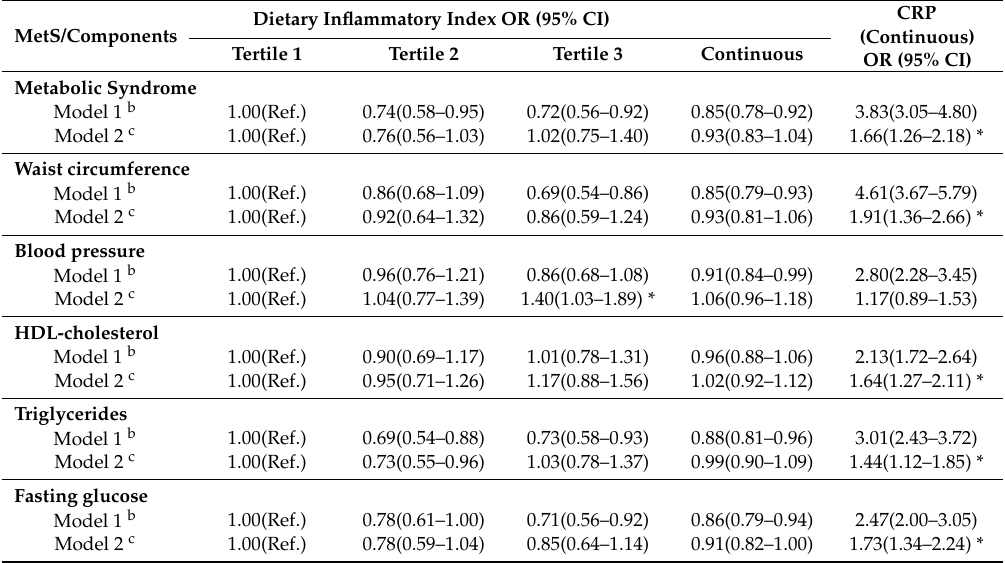
Table 3. Association between the incidence of MetS (components) and DII/CRP a